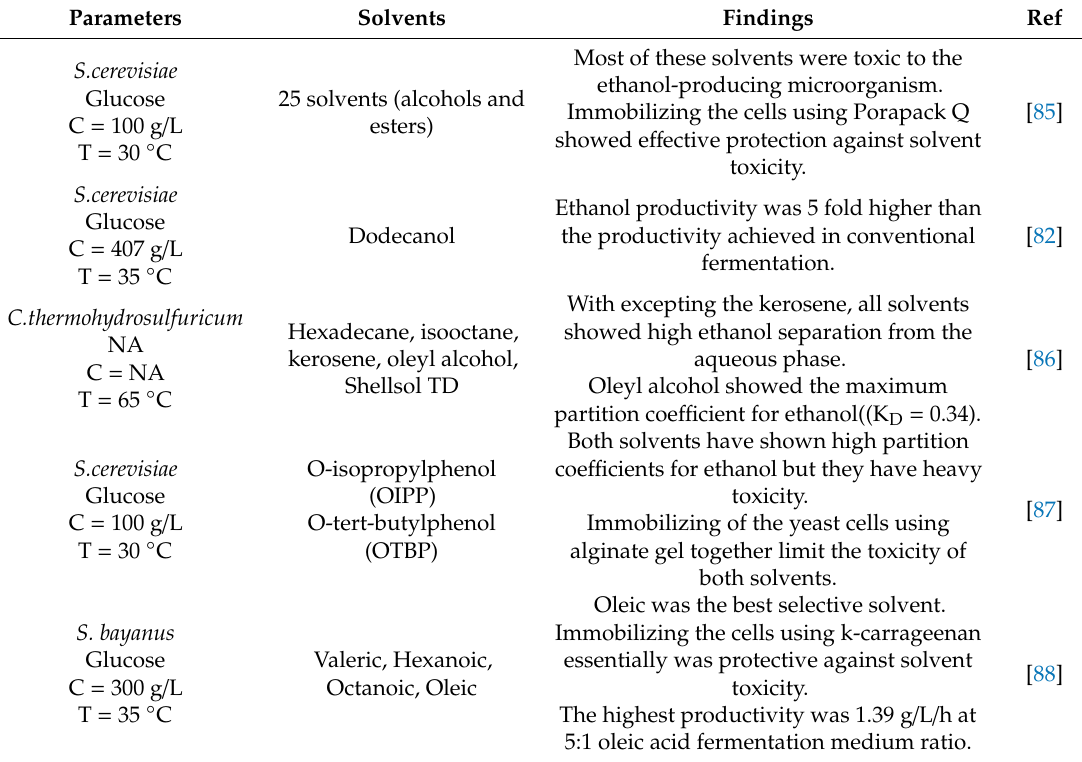
Table 4. Summary of studies about ethanol recovery from the fermentation broth using solvent extraction (C: substrate concentration, P: vacuum pressure, T: